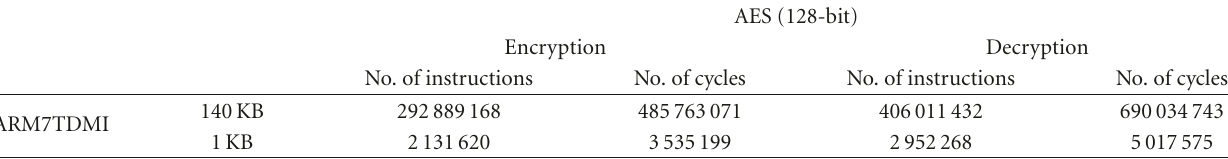
Figure 6: Illustration of SCENARIO 1 3. Table 3: Number of Instructions and Cycles Required for